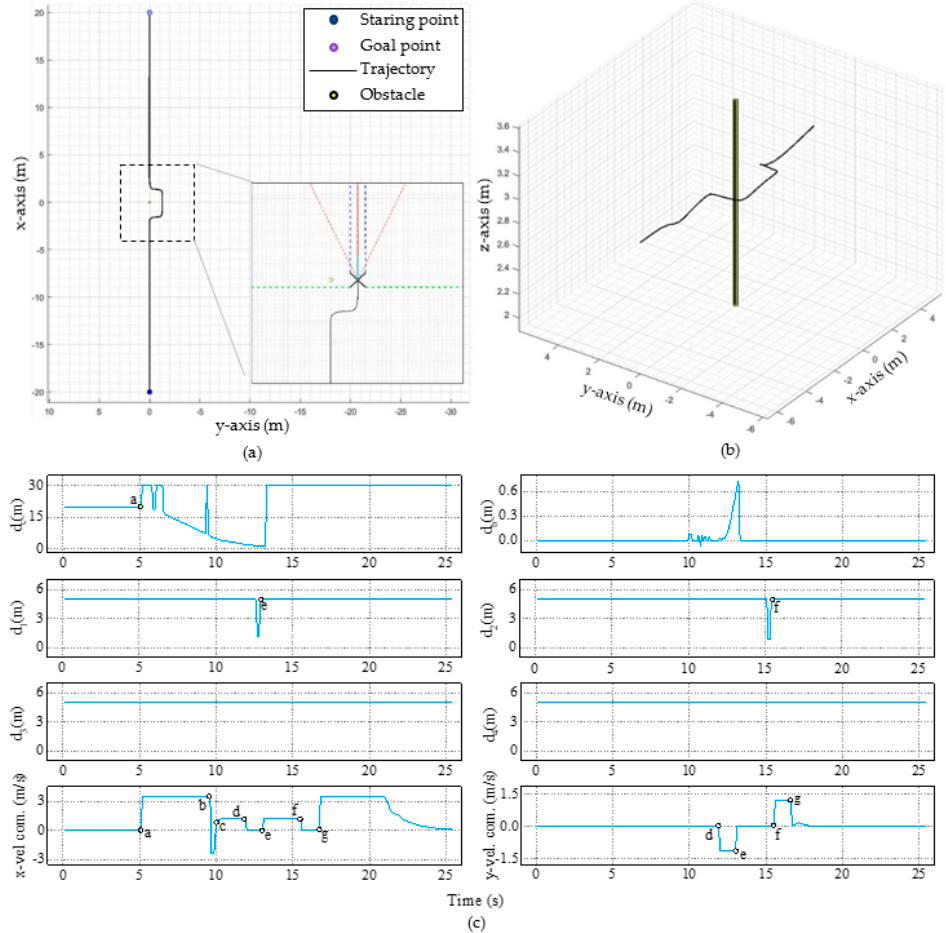
Figure 10. Trajectory of the UAV ( a ) from initial point to goal point with zoom, azimuth: − 90 ◦ , elevation: 90 ◦ ; ( b ) orthographic view, azimuth: − 67 ◦ , elevation: 43 ◦ ; ( c ) flight command and sensor readings. Sensor readings of d b , d c , d 1 , d 2 , d 3 , d 4 , velocity command on x -axis and y To test the effectiveness of the dynamic algorithm, we did multiple simulations by changing the liquid level. We used liquid levels of 0.10 , 0.25 , 0.50 , 0.75 , 0.9 and 1.0 to